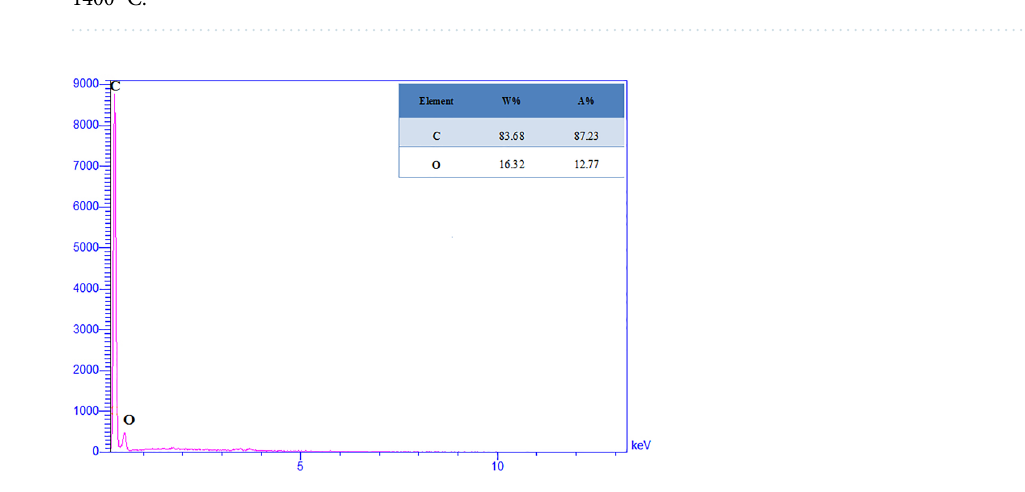
Figure 4. Energy dispersive X-ray spectrum of sample C2.